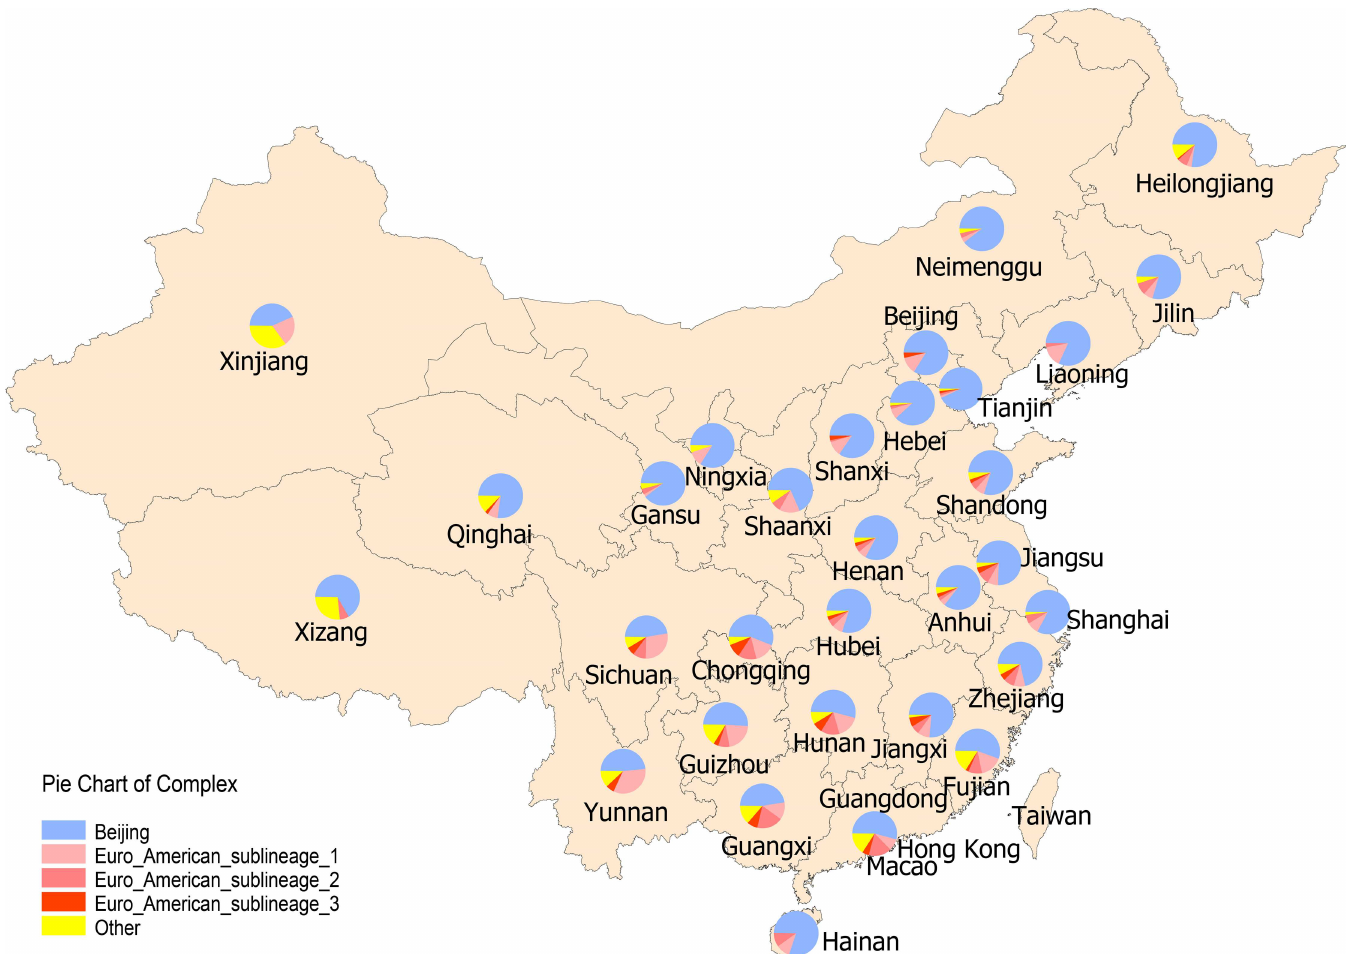
Fig 2. Geographic distribution of the complexes in 31 provinces in mainland of